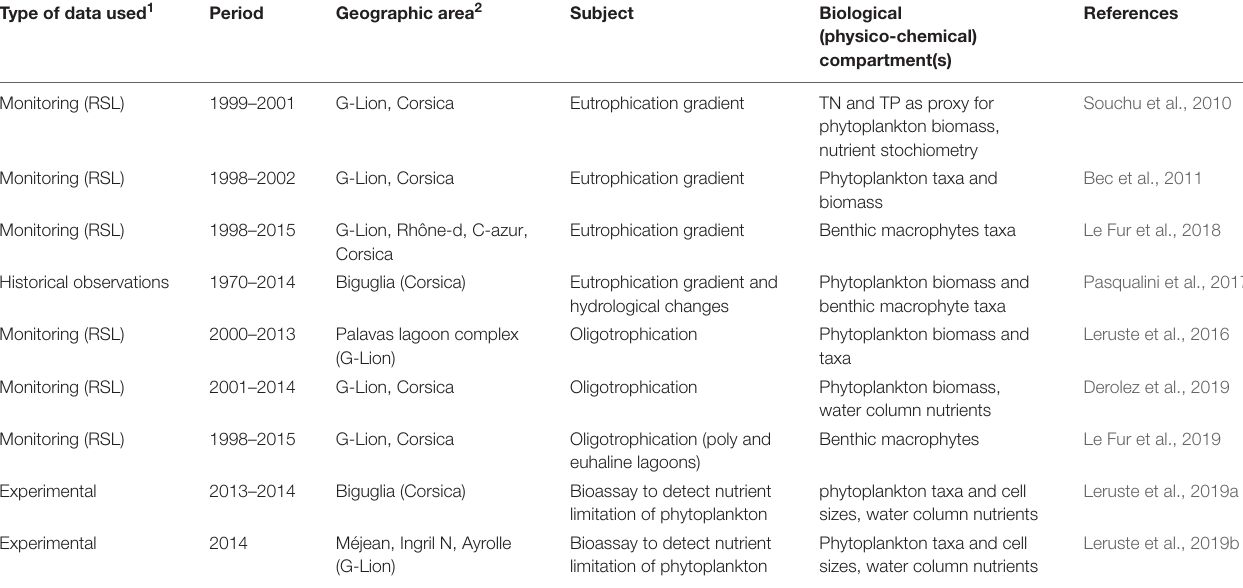
TABLE 1 | Scientific papers used to synthesize and review the information, which served to create the knowledge base about eutrophication gradients and oligotrophication trajectories in shallow Mediterranean coastal lagoons in South France.